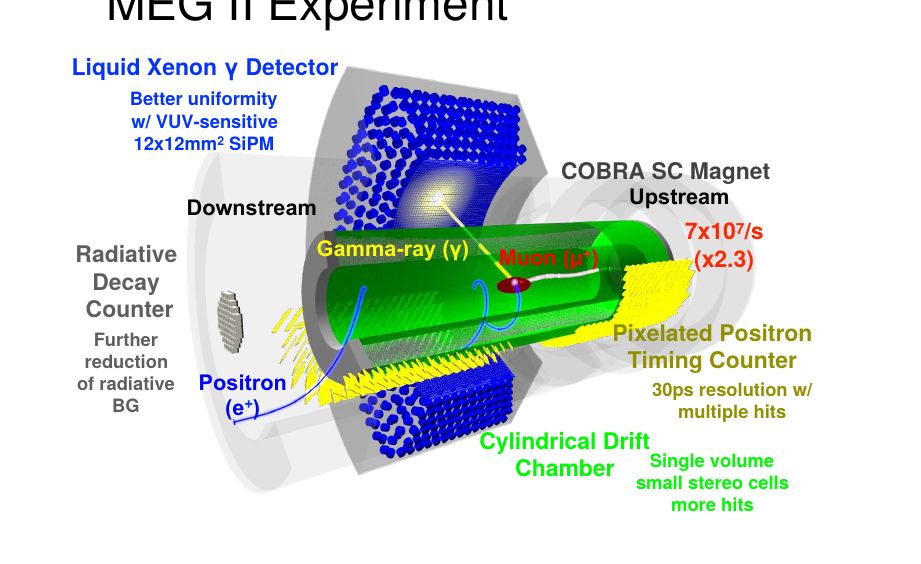
Figure 2: Drawing of the MEG II